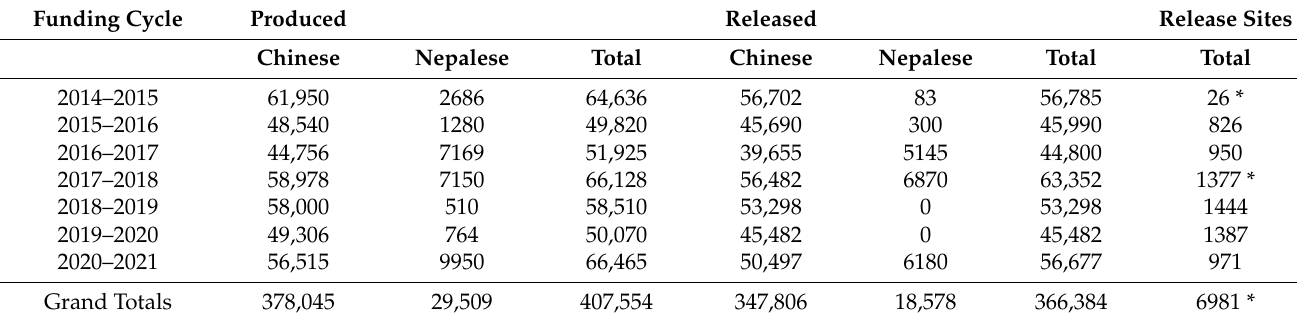
Table 1. The number of the two biotypes of beetles, Chinese and Nepalese, produced and released annually by the Gainesville facility. The grand totals of beetles produced and released from 2014–2021 include the number of sites where beetles were released in Florida and five other states. The asterisks in